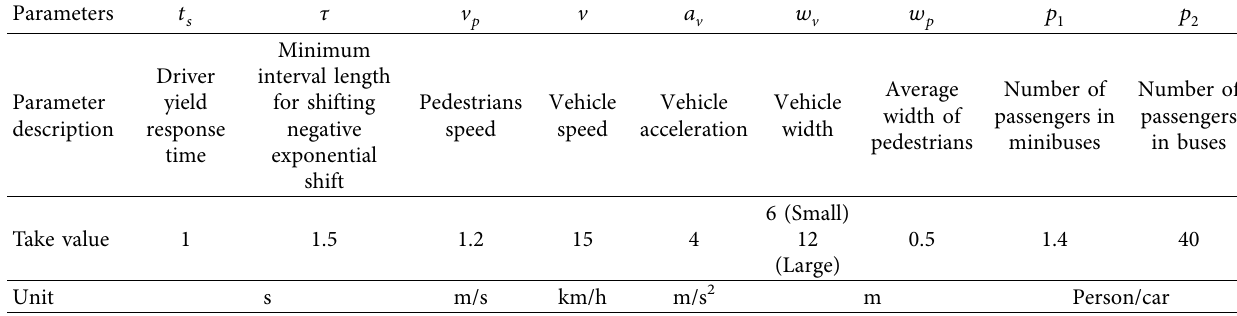
Table 2: Parameter calibration of